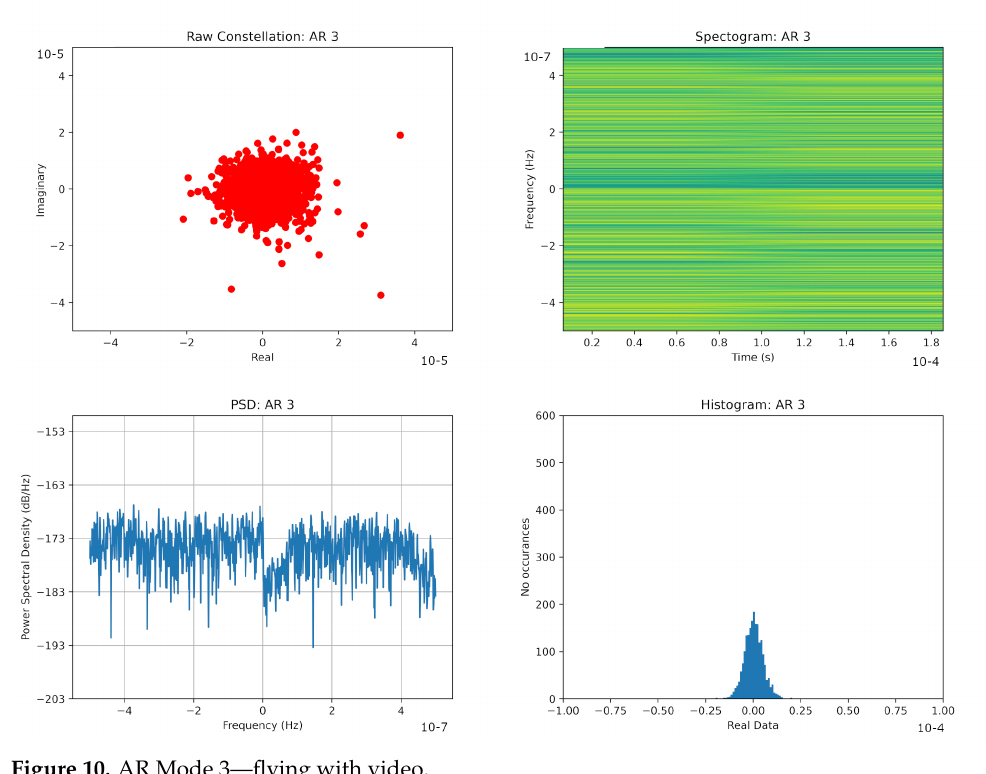
Figure 10. AR Mode 3—flying with video.